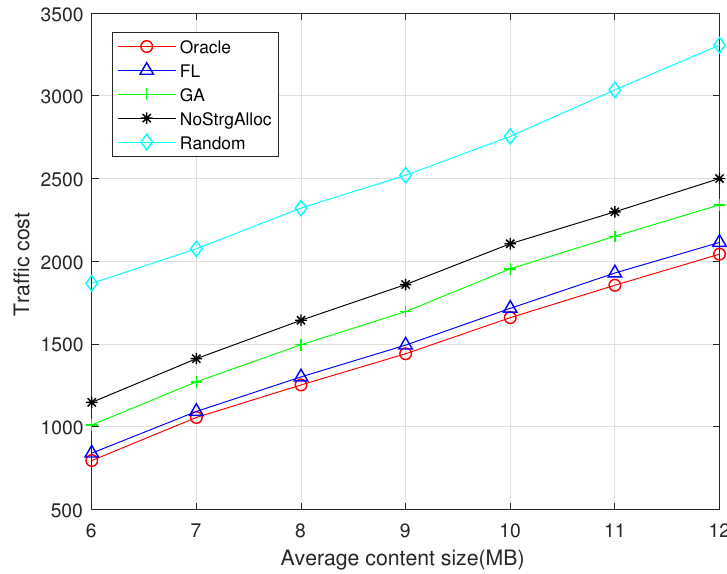
Figure 6. Traffic cost vs average content size (MovieLens